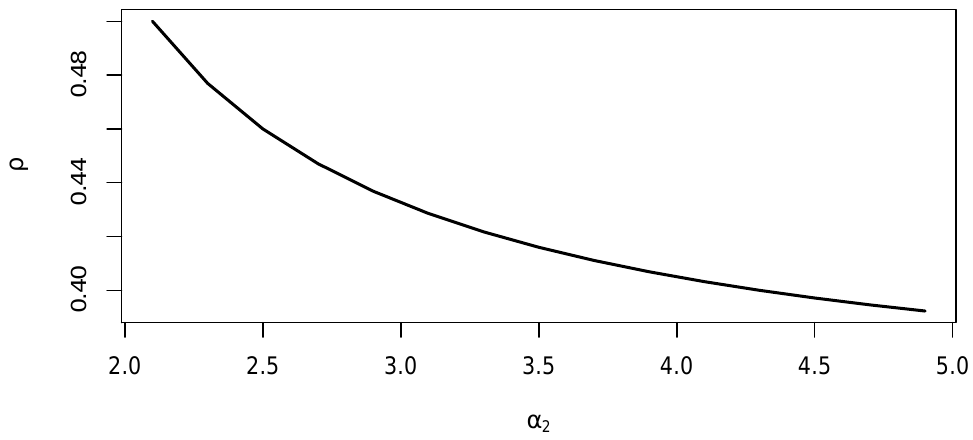
Figure 6. Dependence of the system load, ρ , on the parameter α 2 = 2.1,2.3, . . . ,4.9 of the mixture distribution in an M / G / c system with c = 4, λ = 2.2, mixture, F m of Pareto ( 2.1,1 ) and Pareto ( α 2 ,1 ) service time d.f. with mixing coefficient p =